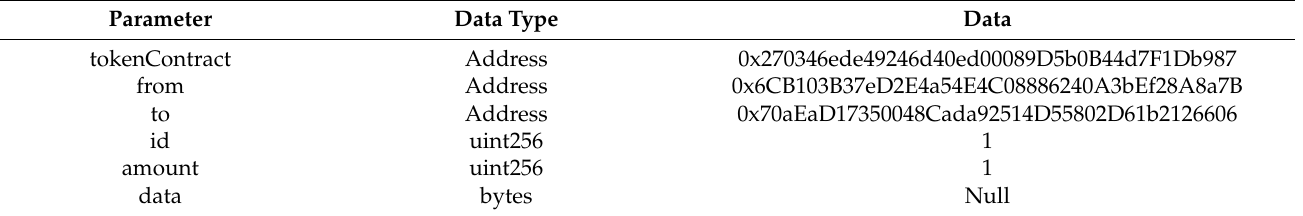
Table 6. Transaction data used in the first